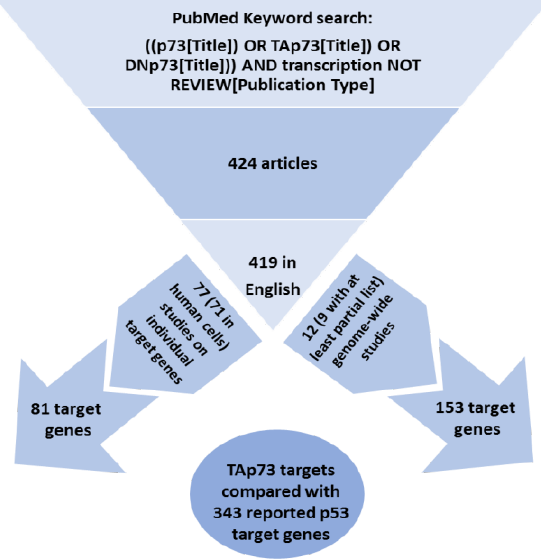
Figure 1. Overview of analysis. The flow diagram depicts the criteria used for the selection of articles reviewed in this report.